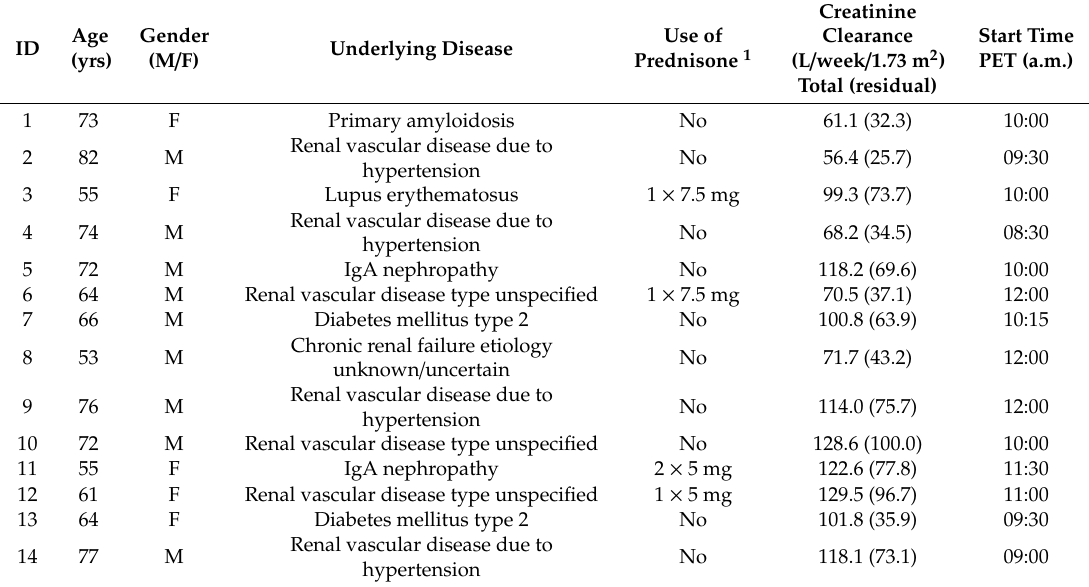
Table 1. Patient characteristics.